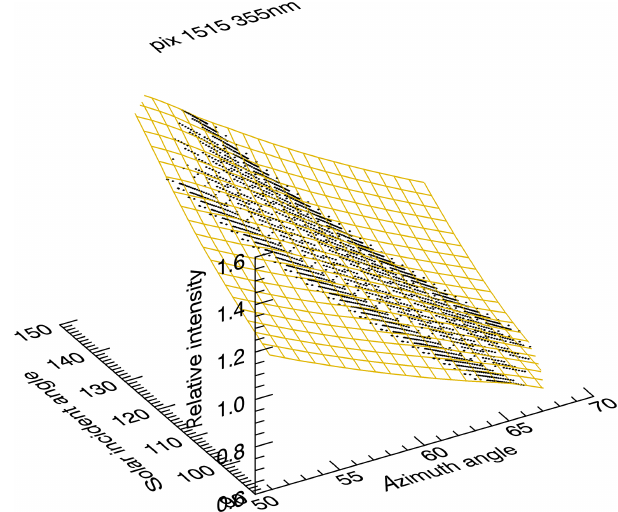
Figure 4. Visualisation of a look-up table (LUT) for the ASM dif- fuser sensitivity. The LUT for 355nm (in channel 2) is shown. The black dots are the measured intensities, relative to the reference measurements (15th readout on 27 February 2003). The overlay is the interpolated LUT. The LUT values depend on the incident angle of the solar irradiance and the azimuth angle between the solar and the ESM incidence